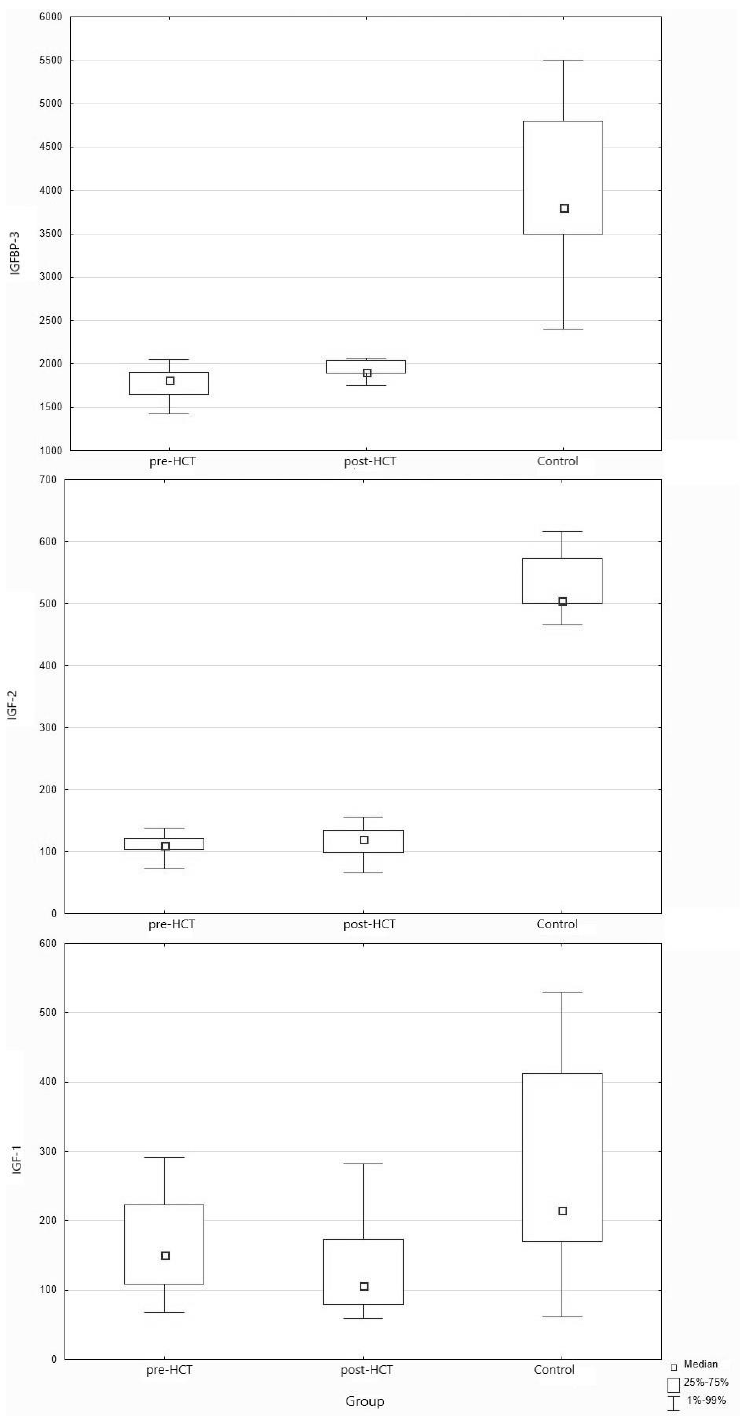
Figure 1. Concentrations of IGF-1, IGF-2 and IGFBP-3 (ng/mL) in pre-HSCT group, post-HSCT group, and healthy controls. HSCT, hematopoietic stem cell transplantation; IGF, insulin growth factor; IGFBP, insulin growth factor-binding protein.